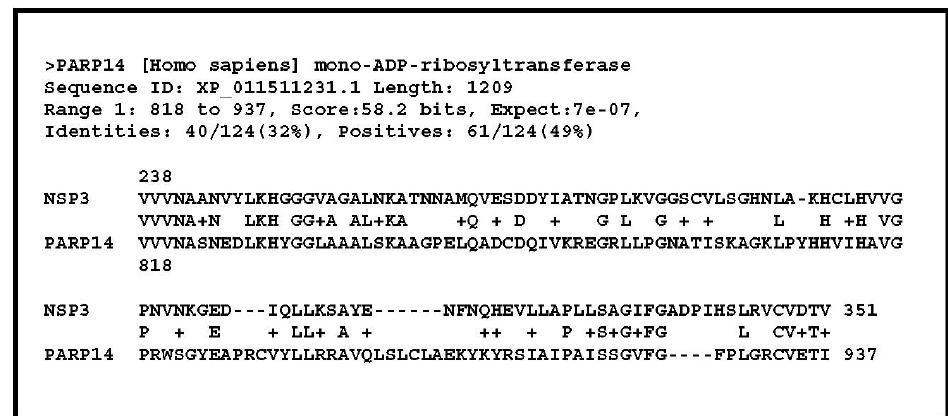
Figure 3. Best match from the BlastP similarity search output of the entire SARS-CoV-2 nsp3 protein (1935 residues) against the human proteome subset of the NR database. This unique match precisely corresponds to the ADP-ribose binding site, central to the viral macrodomain defined by previous structural studies [11].